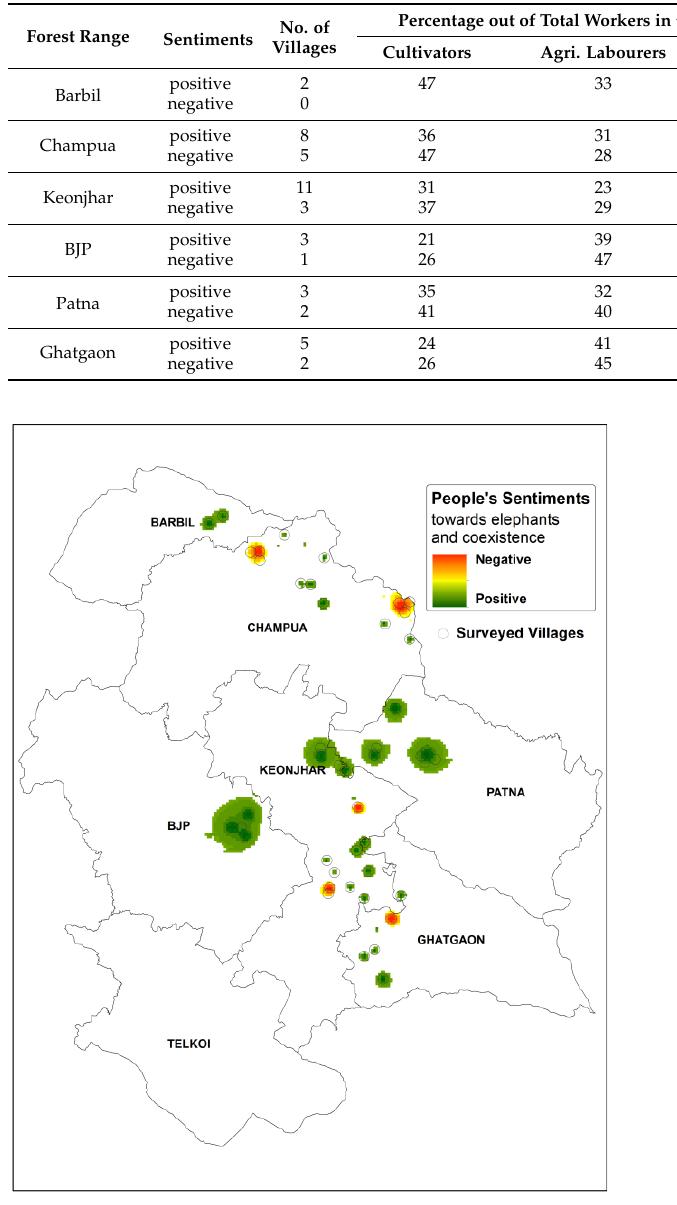
Figure 2. Map showing people’s sentiments towards elephants and coexisting with them in the human-elephant conflict hotspot regions, where green regions are showing people’s positive senti- ments whereas red regions represent negative sentiments.